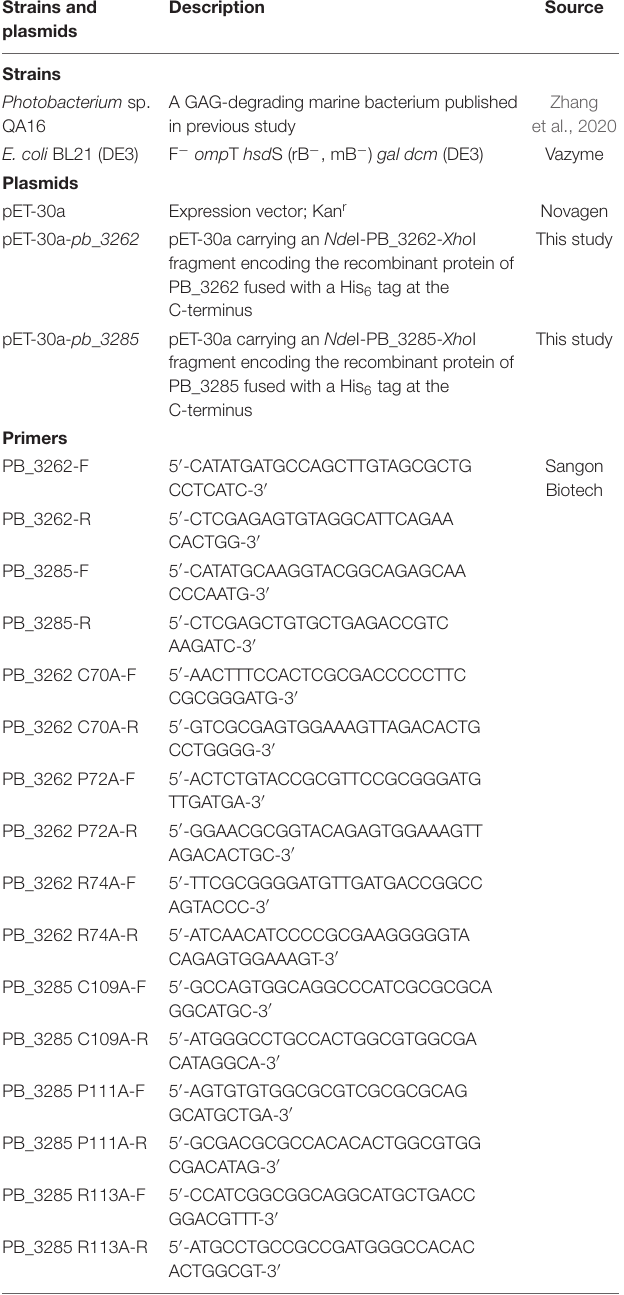
TABLE 1 | Strains, plasmids and primers of PB_3262 and PB_3285 used in this study. Strains and